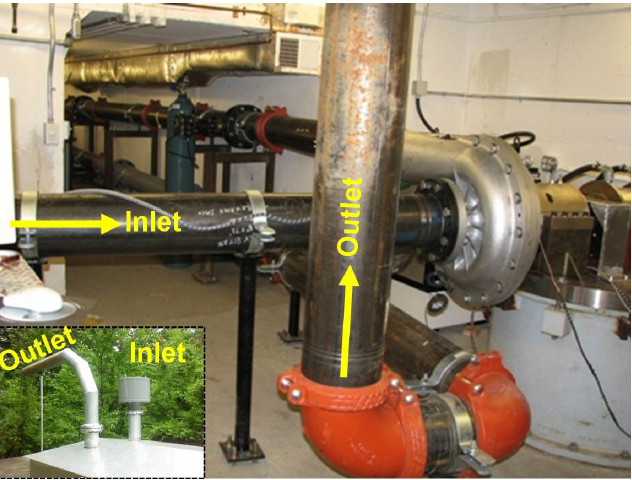
Figure 12. The compressor and piping system.